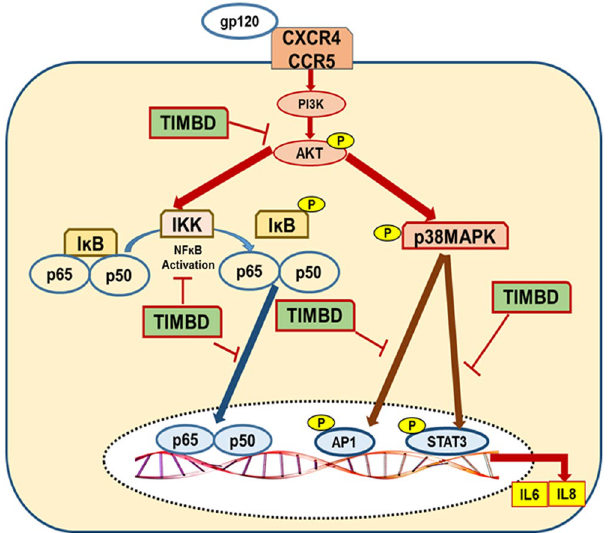
Figure 6. Schematic illustration of the suggested mechanism for inhibition of gp120-induced IL6 and IL8 by TIMBD in SVG